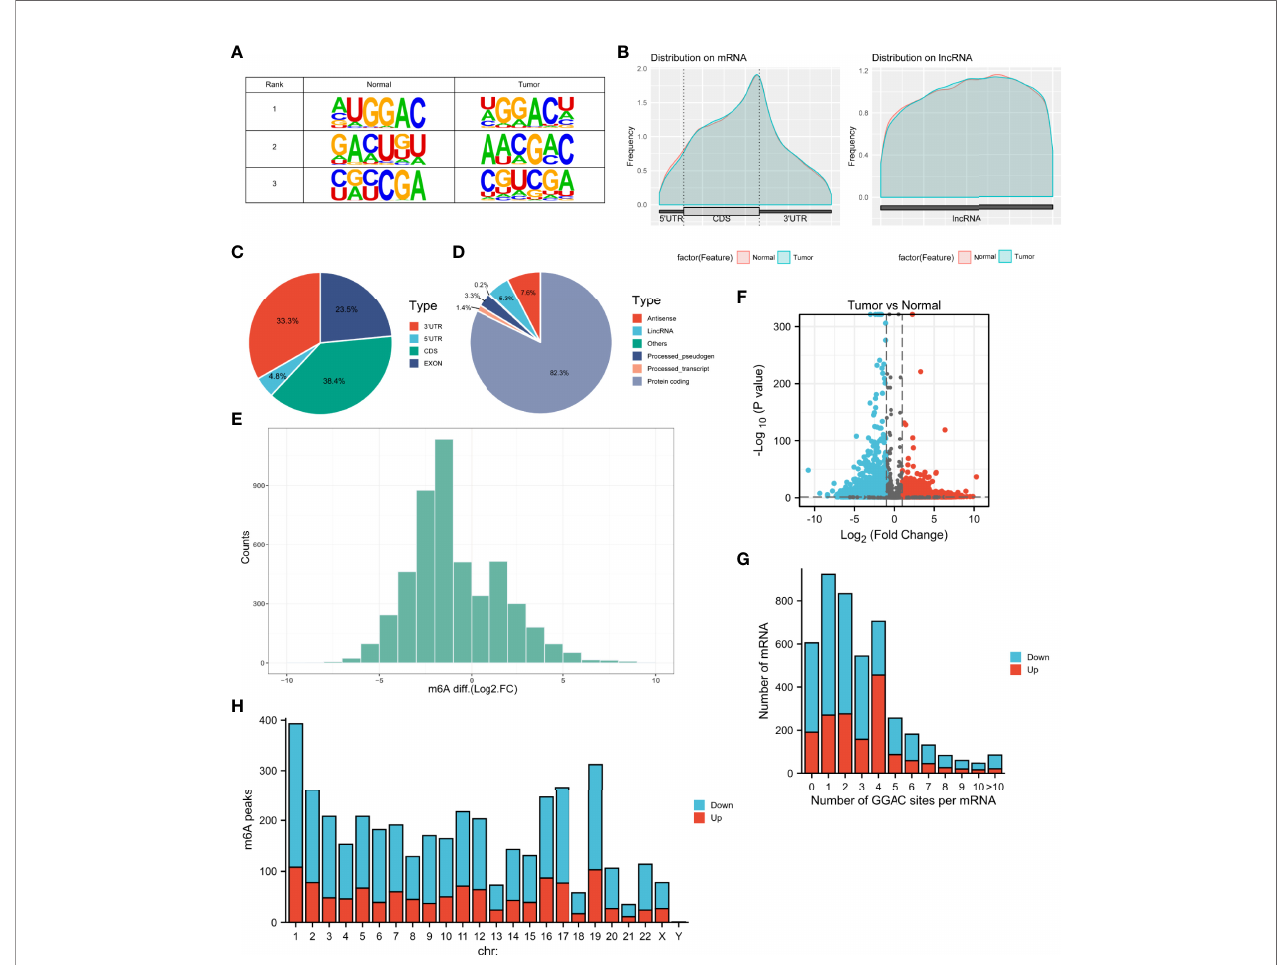
FIGURE 1 | Characteristics of m6A methylation in LUAD. (A) The sequence logo showed the top three m6A motifs. (B) The distribution of m6A peaks in normal and tumor tissues. (C, D) Pie charts showing the distribution of differently methylated m6A peaks. (E) Histogram showing the changes in m6A enrichment between normal and tumor samples. (F) Volcano plots show signi fi cantly different m6A peaks. (G) The distribution of altered GGAC sequence per mRNA. (H) The distribution of differentially methylated m6A peaks in human chromosomes. Fold change ≥ 2 and P <